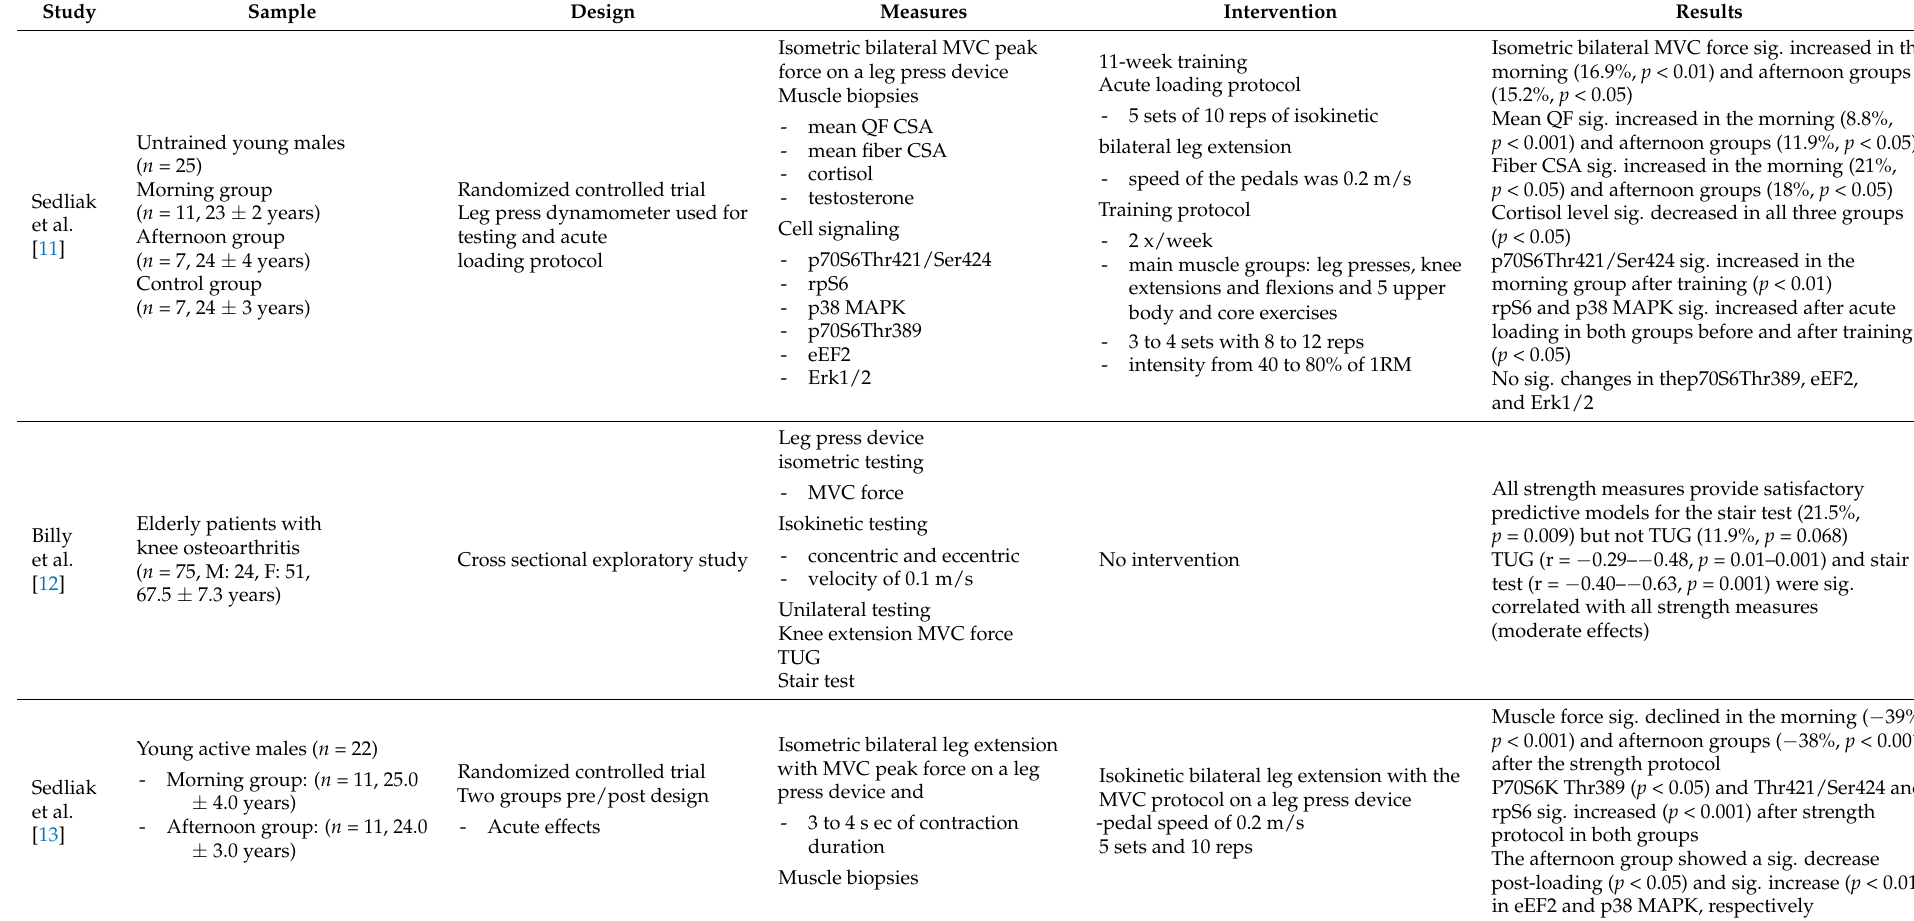
Table 2. Acute/testing studies using a leg press